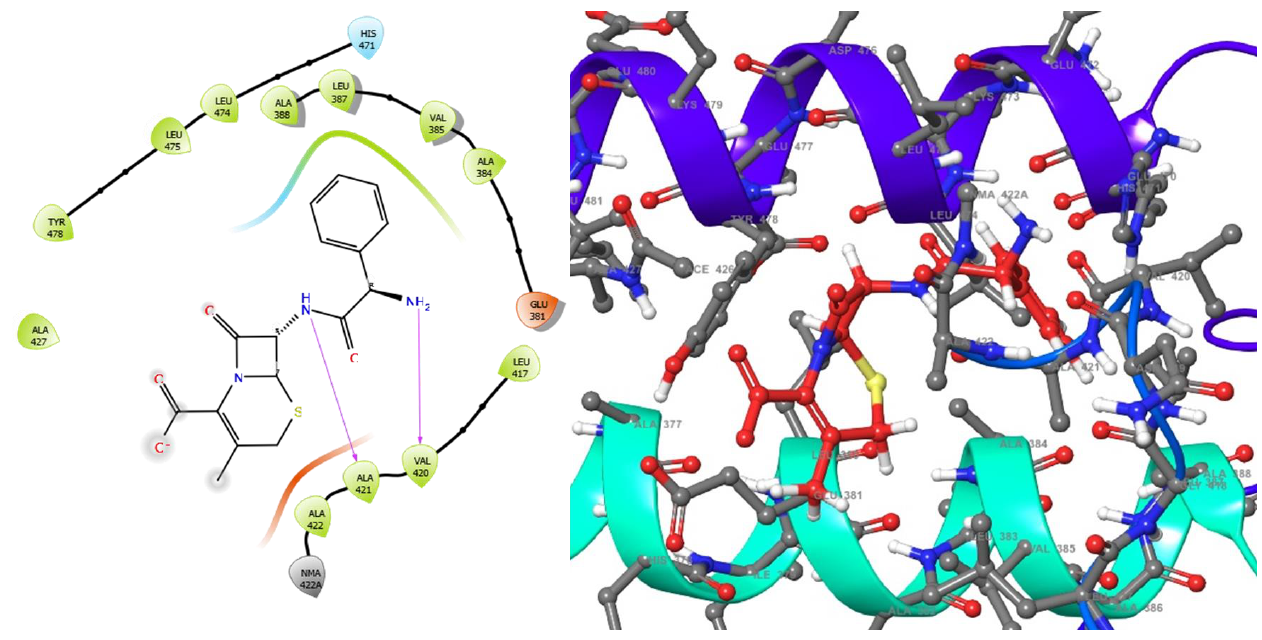
Figure 5. 2D ( left ) and 3D ( right ) views of the molecular interactions at the surface of the active site of the E. coli DNA gyrase–DNA binding and cleavage domain in State 1 after binding with cephalexin (the green stick model). The negative, positive, and neutral charges of the binding site residues are represented with red, blue, and white colors, respectively.